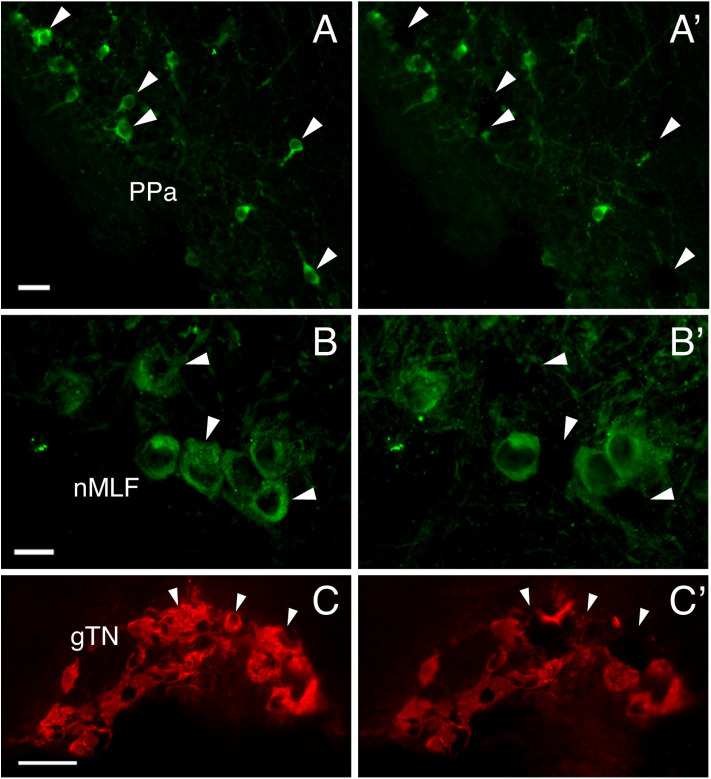
Photomicrographs of GnRH-GAP immunoreactive cell somata before (A–C) and after (A'–C') microdissection. Arrows indicate harvested cell somata of GnRH-GAP1 (A,A') in the anterior part of the parvocellular preoptic nucleus (PPa), GnRH-GAP2 (B,B') in the nucleus of the medial longitudinal fascicle (nMLF) and GnRH-GAP3 (C,C') in the terminal nerve ganglion (gTN). Scale bars, (A,B), 20 μm; (C) 50 μm.